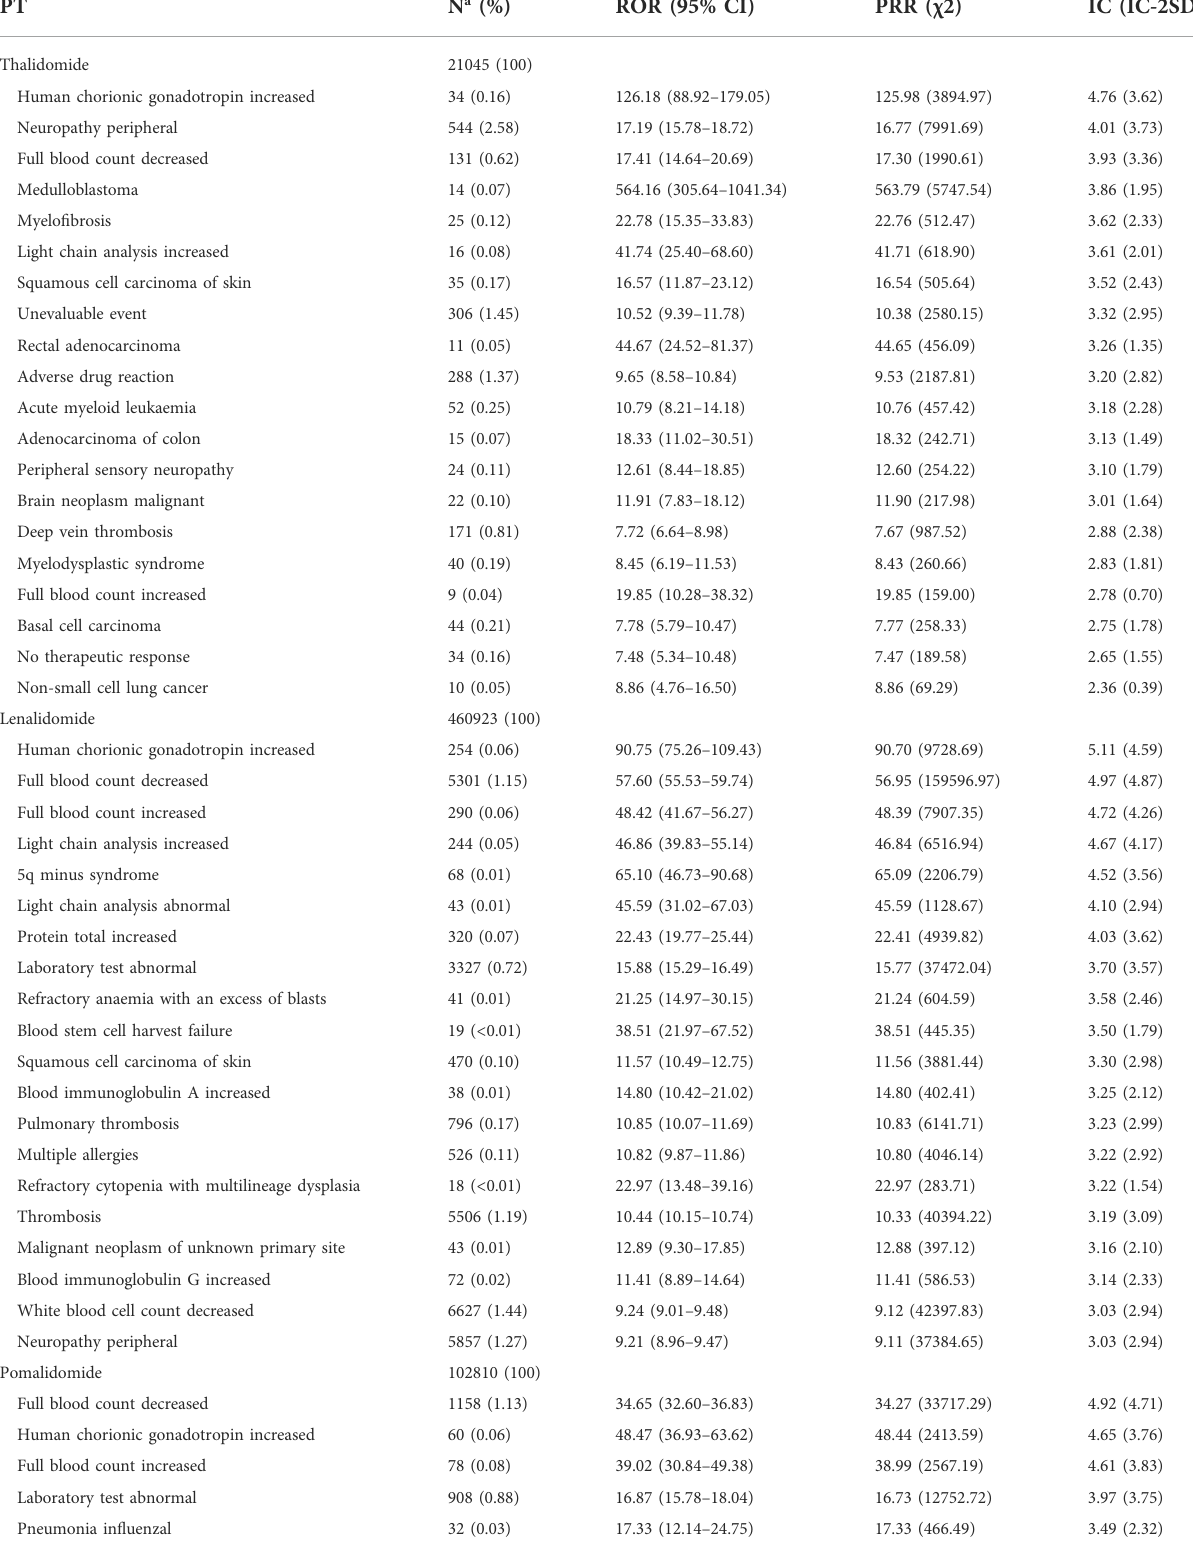
TABLE 4 Top 20 preferred terms (PT) associated with immunomodulatory drugs (IMiDs) for signal strength. PT N a (%) ROR (95% CI) PRR ( χ 2) IC